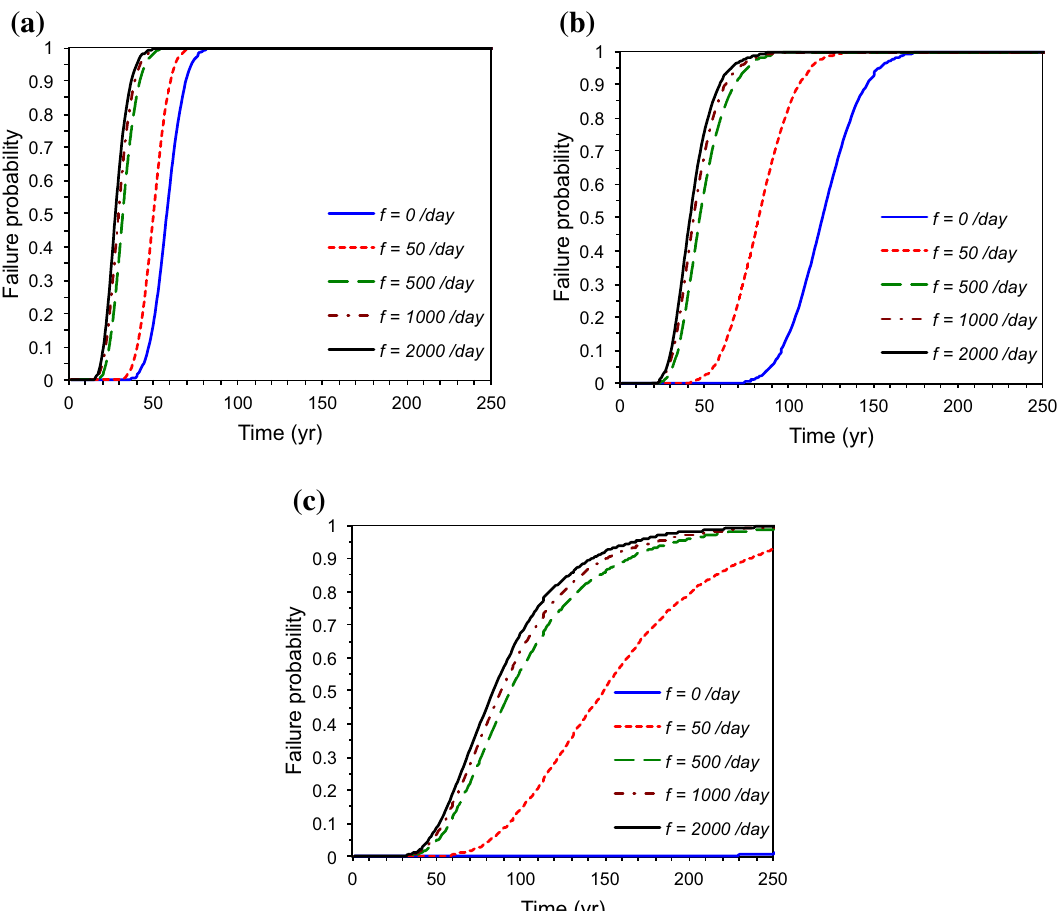
Fig. 5 Failure probabilities for the tropical environment under a high; b moderate and c low aggressiveness